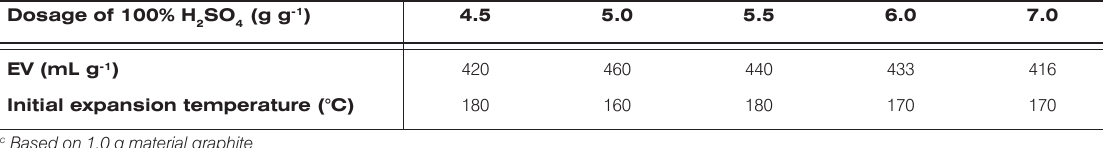
SO dosage on EG initial expansion temperature and EV c . 2 4